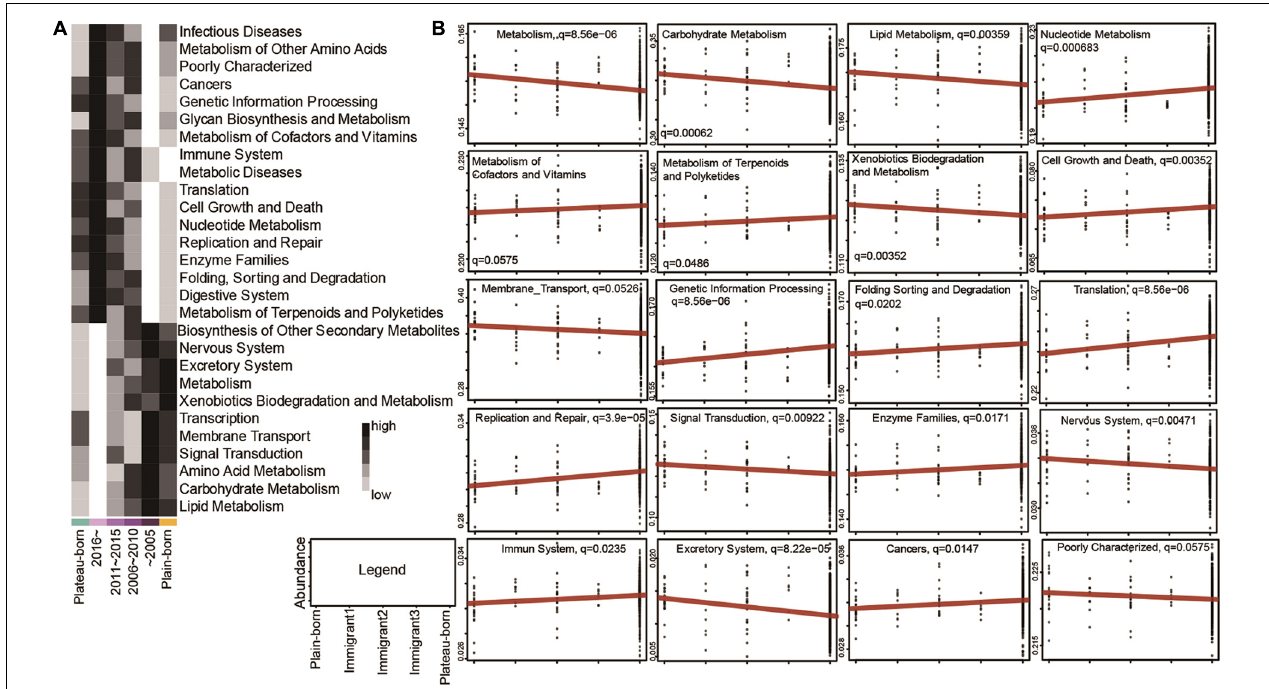
FIGURE 5 | Altitude migration affects the physiological function and disease incidence in the Tibetan population. (A) Abundance of predicted KEGG pathways significantly correlated with the year of emigration from plateau to plain (Spearman’s correlation, adjusted P < 0.05); colors of heatmap mean lower abundance or higher abundance in different groups. (B) Relative abundance of 20 predicted KEGG pathways which were significantly correlated with immigration generations from plain to plateau (MaAsLin q -value < 0.1).